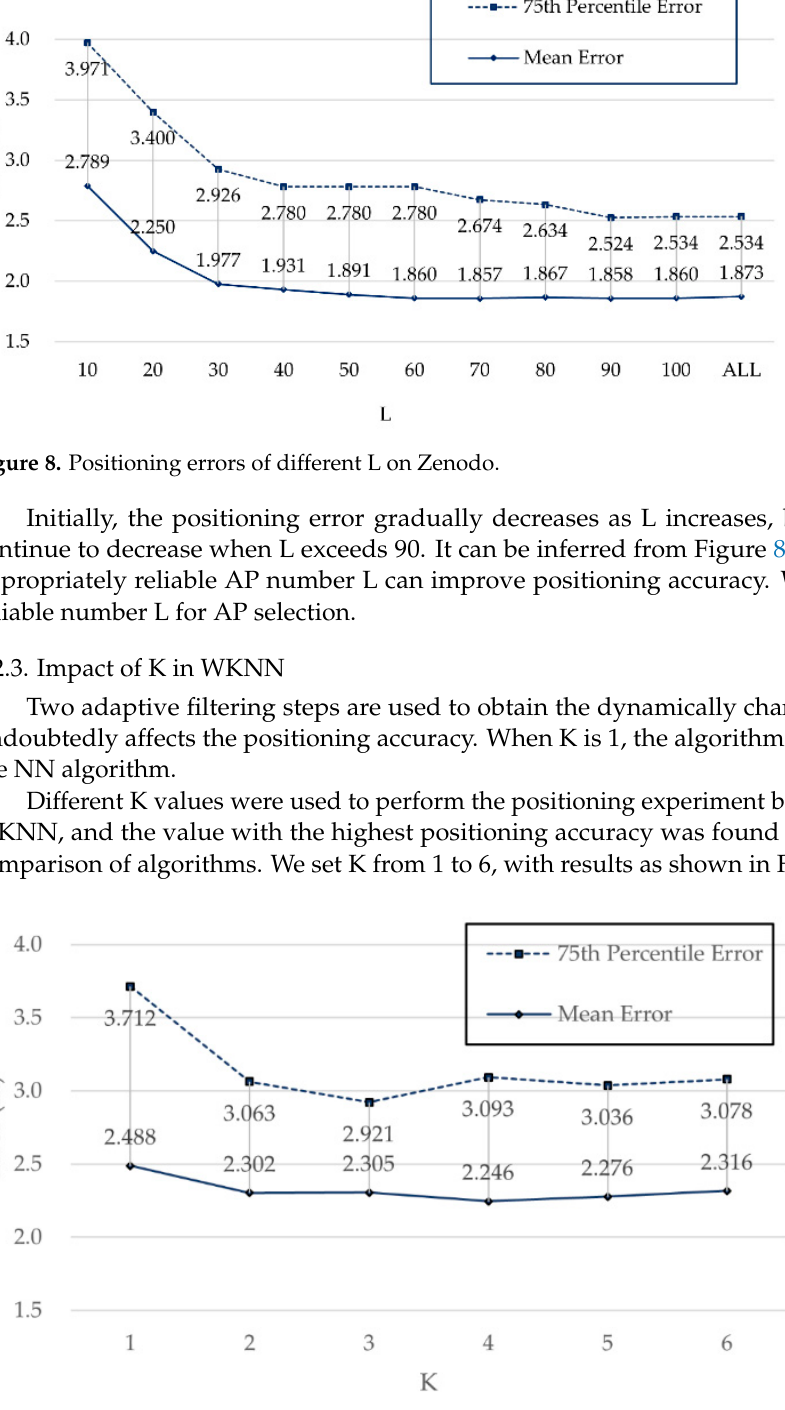
Figure 8. Positioning errors of different L on Zenodo.